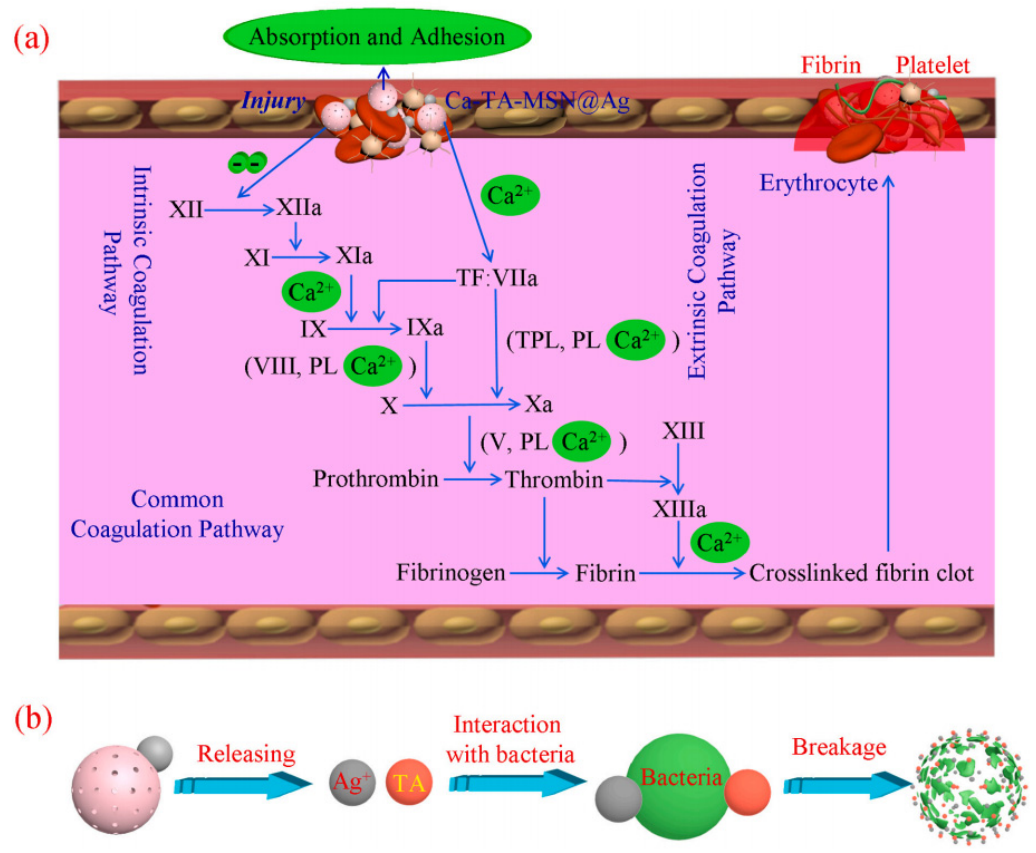
Figure 11. The potential ( a ) hemostatic and ( b ) antibacterial mechanism of Ca-TA-MSN@Ag. Repro- duced with permission from Ref. [133], Copyright 2021, Elsevier.